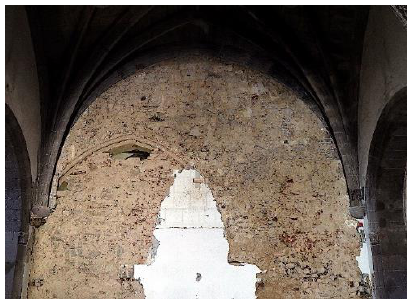
Figure 3 . Points of TLS survey